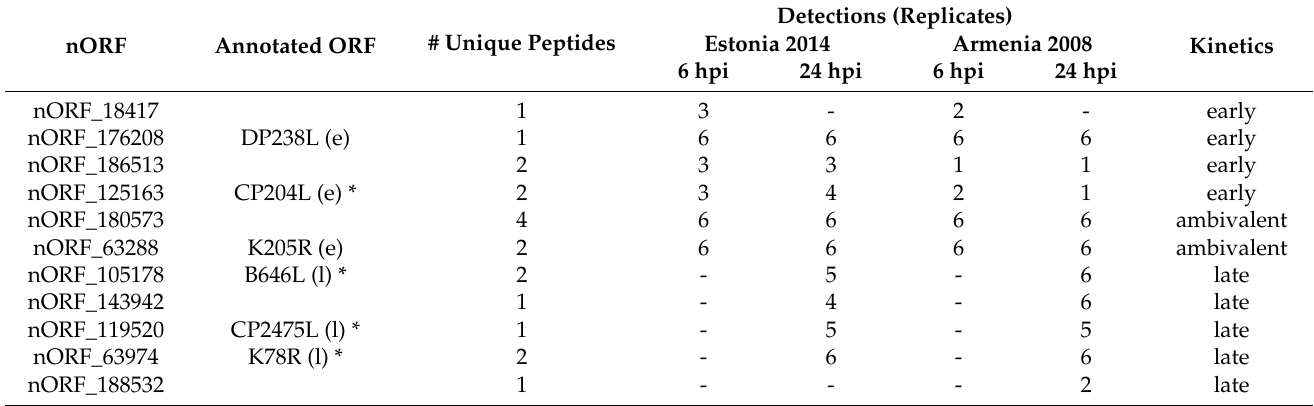
Table 1. Identification of proteins corresponding to novel open reading frames (nORFs)